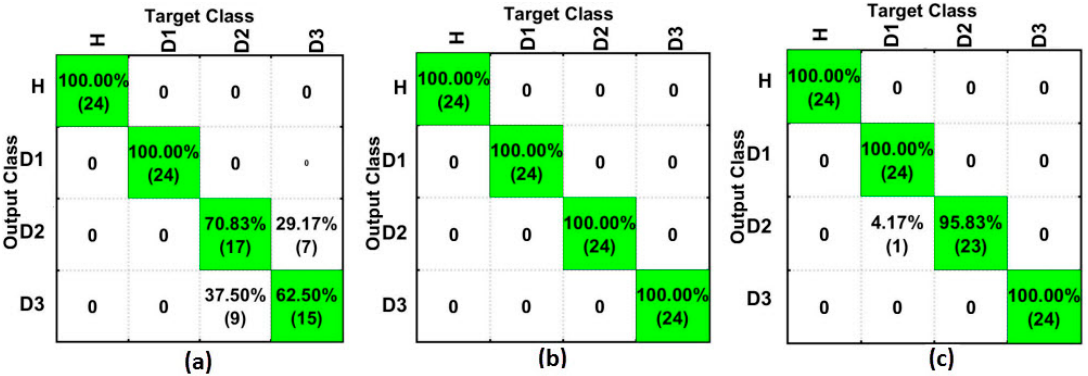
Figure 12. Results for the SFAN-based method (time domain) considering only Savitzky-Golay + Second Derivative (SGSD) for: ( a ) PZT#1; ( b ) PZT#2; and, ( c ) PZT#3.